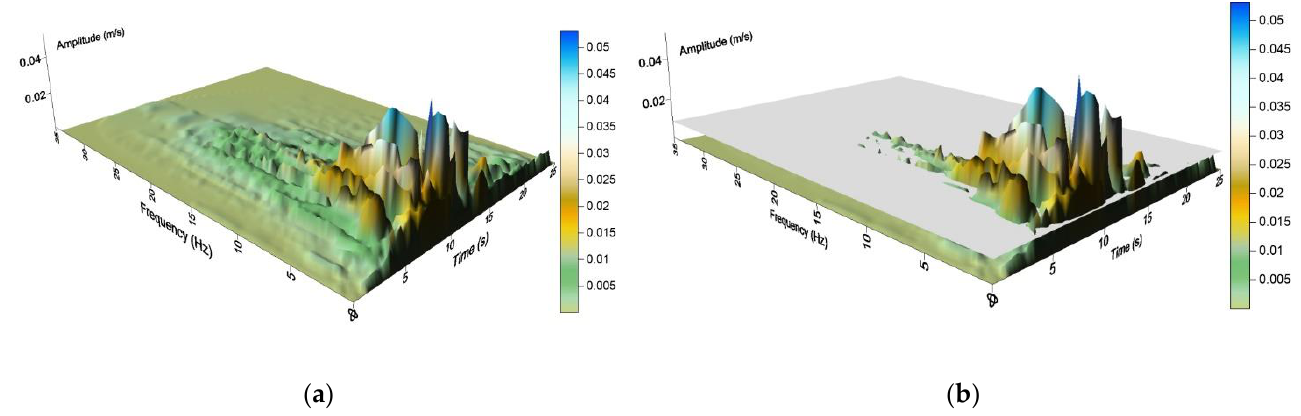
Figure 2. ( a ) Hilbert spectrum (HS) for a seismic excitation; ( b ) bounded HS with the layer that crosses the amplitude-axis of HS at A mean,HHT .